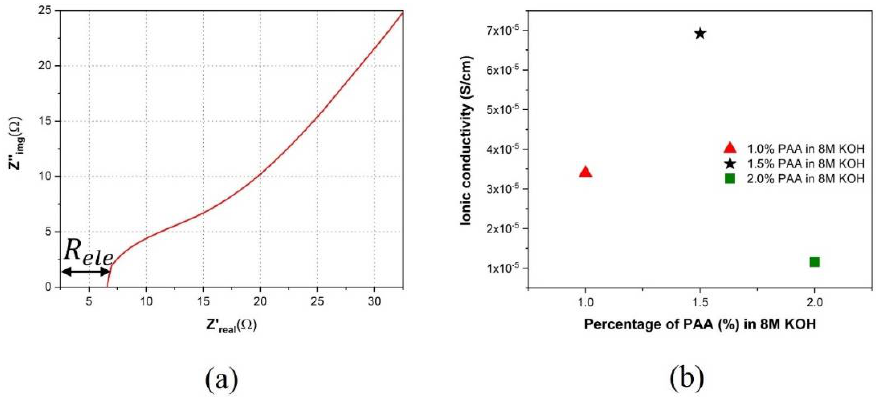
Figure 7. ( a ) EIS plot of the gel electrolyte with 1.5 wt% PAA; and ( b ) plot illustrating the effect of PAA wt% on the ionic conductivity of the gel electrolyte.